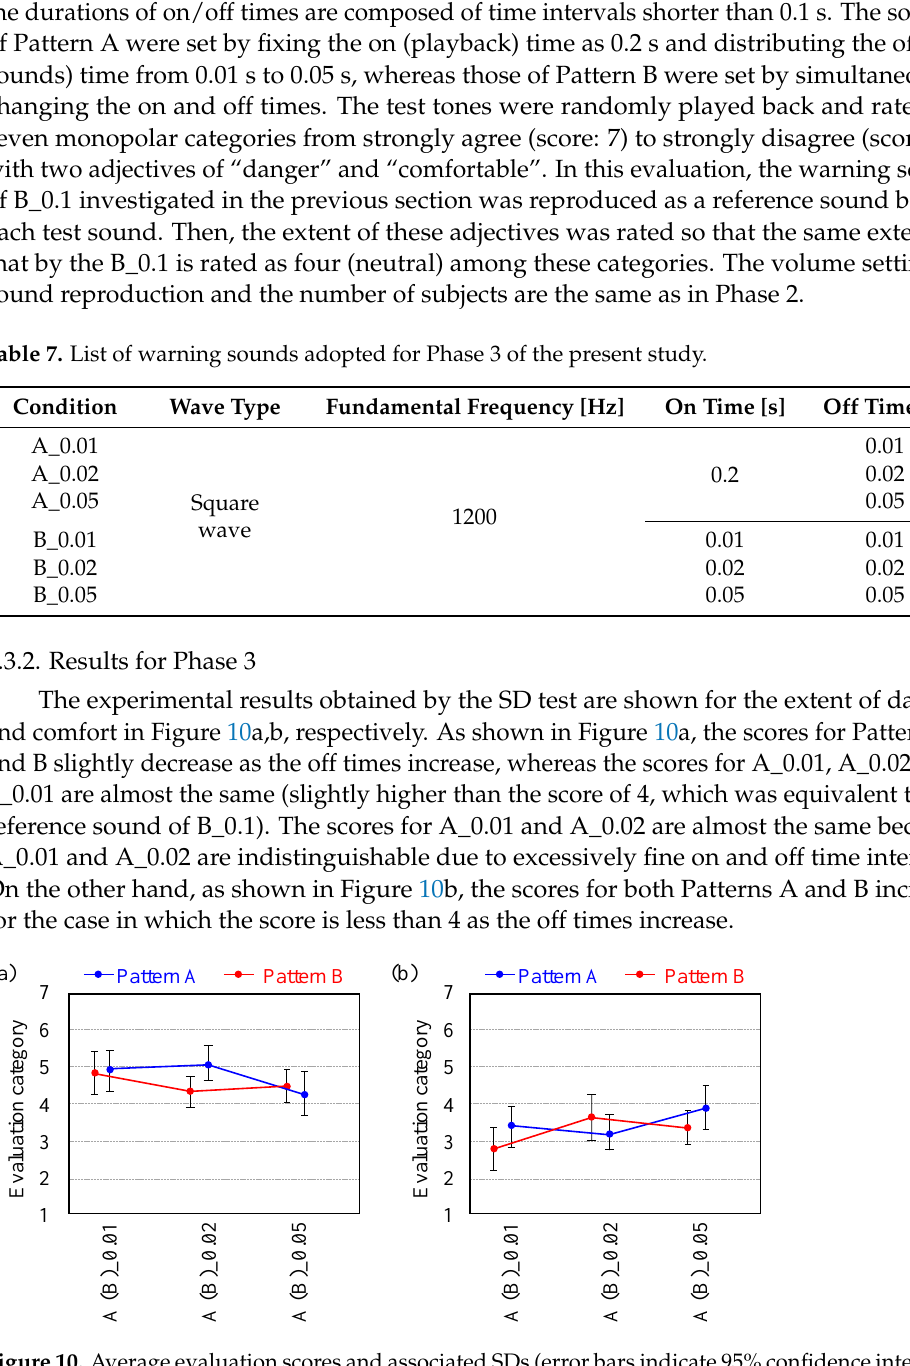
Figure 10. Average evaluation scores and associated SDs (error bars indicate 95% confidence intervals) for the extent of ( a ) danger and ( b ) comfort.